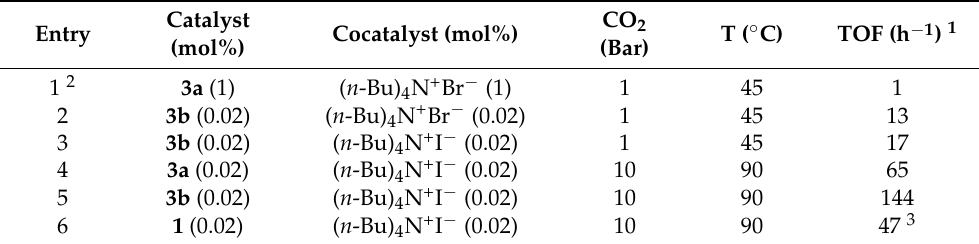
Table 1. Cyclic carbonate synthesis using salen-Al catalysts and tetrabutylammonium halides.